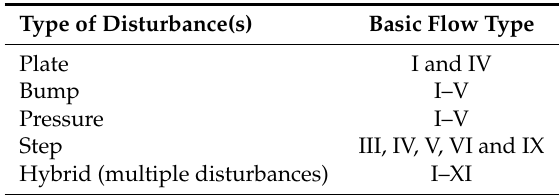
Table 1. Summary of